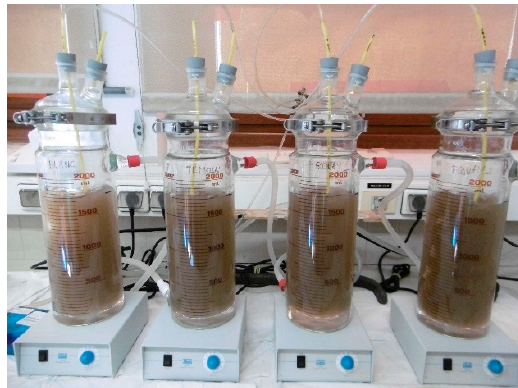
Figure2. OrganizationforEconomicCo-operationandDevelopment(OECD)testforthebiodegradation Figure 2. Organization for Economic Co-operation and Development (OECD) test for the of a fire-fighting foam containing a polyfluoroalkyl biodegradation of a fire-fighting foam containing a polyfluoroalkyl ether.